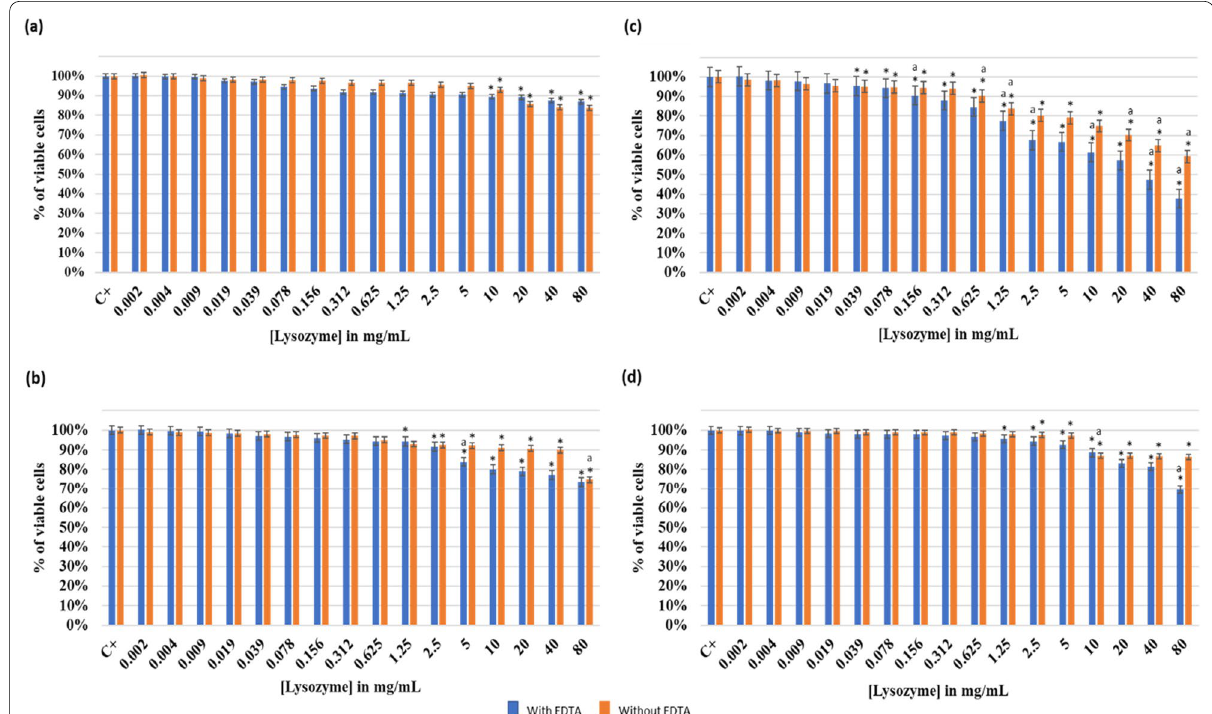
Fig. 3 Effect of lysozyme with and without EDTA (1 mM) on the co-culture of Lactobacillus rhamnosus GG and Staphylococcus epidermidis 444 at different pH: a pH 2; b pH 6; c pH 7.5 and d pH 8.5. The results are mean values of three replicates. OD 600 of the positive controls: C + (a) C + (b) 1.15; C + (c) 1.19;C + (d) 1.40. (*) indicates a significant difference (P < 0.05) between each test and the positive control (without lysozyme). = = = The lowercase letter a indicates a significant difference (P < 0.05) between each test and its preceding. Error bars represent the SD (standard